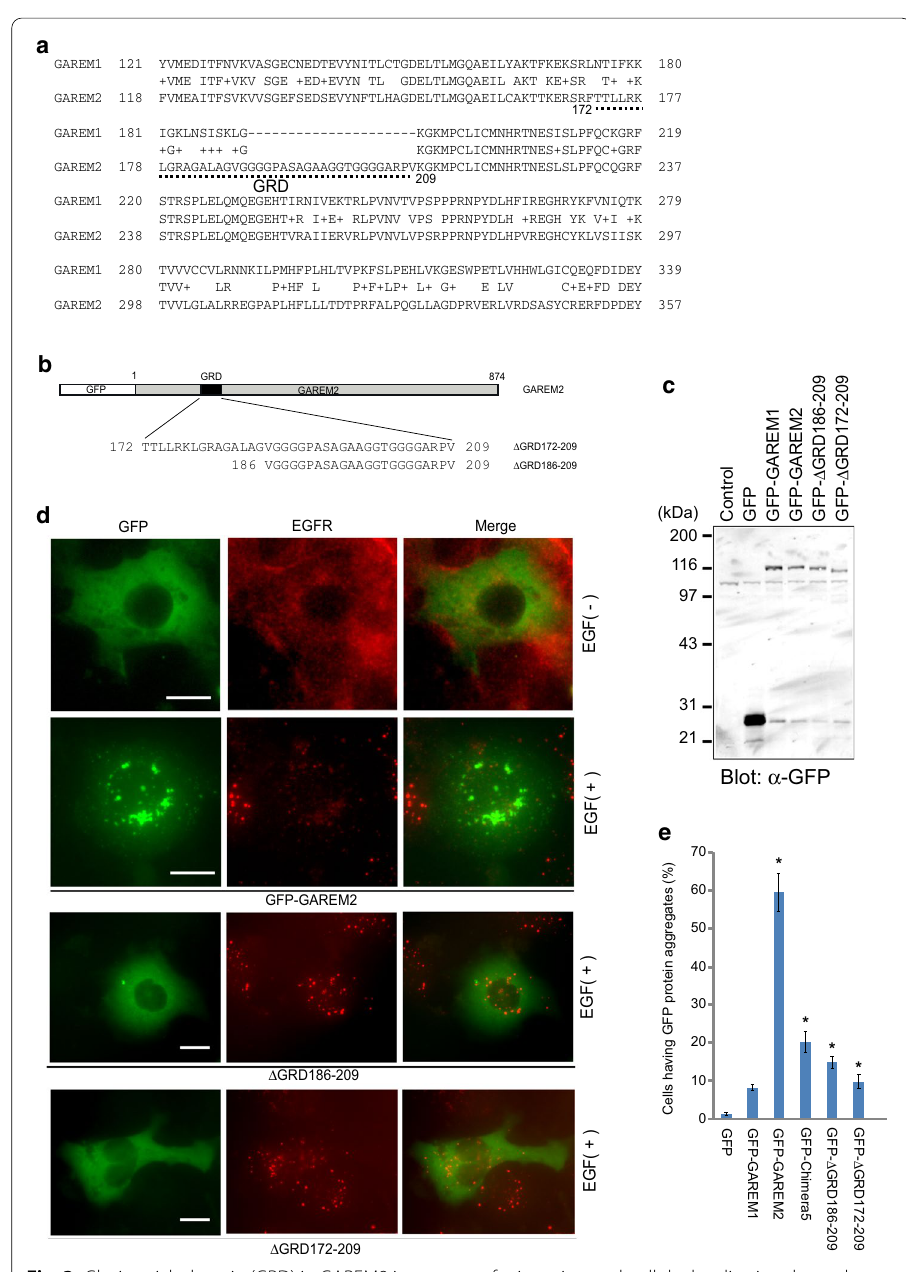
Fig. 3 Glycine-rich domain (GRD) in GAREM2 is necessary for its unique subcellular localization dependent on EGF stimulation. a Amino acid sequences of the N-terminal region of GAREM1 (upper) and GAREM2 (lower) are indicated as numbers. GAREM2-specific glycine-rich domain (GRD) is indicated by broken line. b Schematics of the primary structure of full length GAREM2 (upper) and its deletion constructs lacking GRD (∆GRD186-209 and ∆GRD172-209). c All recombinant proteins were expressed as the N-terminal GFP-fused form. Each construct was transfected into COS-7 cells. Confirmation of expressing GAREM proteins by immunoblotting using with GFP antibody. d COS-7 cells expressing GFP-GAREM2 proteins with [EGF( )] + or without [EGF( )] EGF stimulation for 30 min were immunofluorescently stained using anti-EGF receptor − antibody. Subcellular localization of the full-length and deletion mutant constructs of GFP-GAREM2 (green) and EGFR (red). Representative results are shown. Merged images are indicated in the right panels. Scale bars 10 μm. e Extent of aggregation of wild-type and mutant GFP-GAREM2. Approximately 100 GFP = positive cells were observed. Data are means S.E. (n 5). * P < ± =